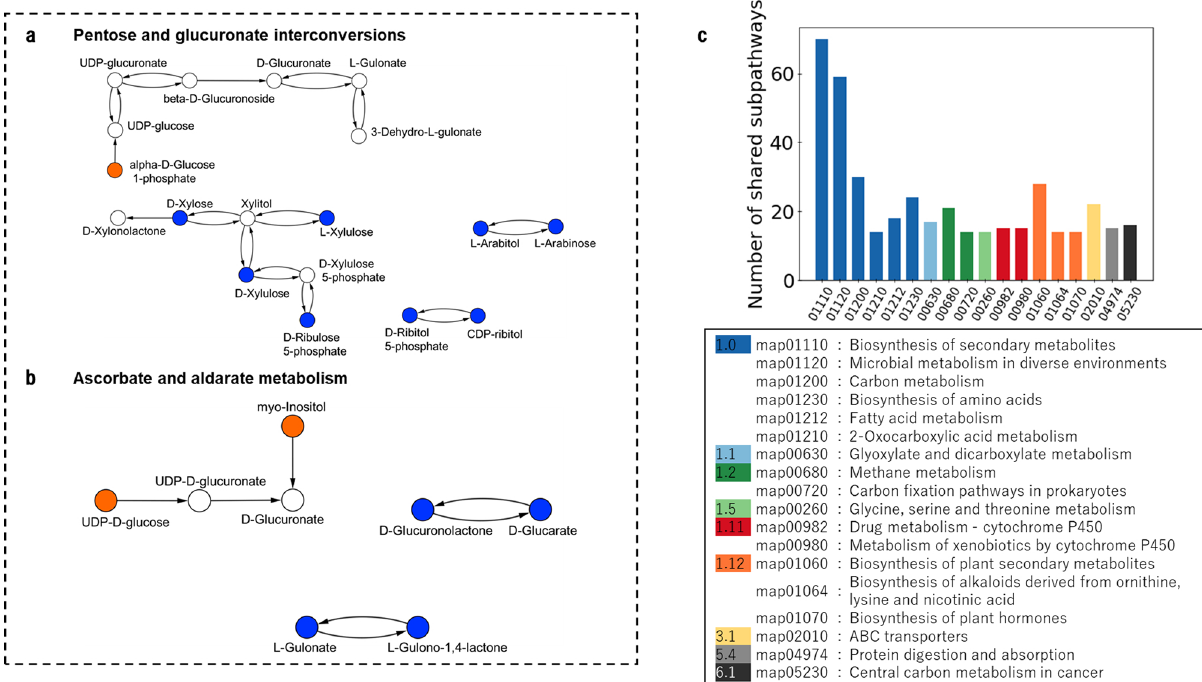
Figure 3. Networks ( a , b ) show that same pathways as shown in Fig. 2a,b with nodes classified according to driven control categories using the proposed algorithm. ( a ) While the pentose and glucoronate interconversion metabolism reveals one critical node (orange), ( b ) the ascorbate and aldarate metabolism shows two critical nodes. Blue circles denote intermittent driven nodes and white circles indicates redundant driven nodes. ( c ) The identified critical driven chemical compounds (265) are shared by many other functional pathways in the human metabolism.